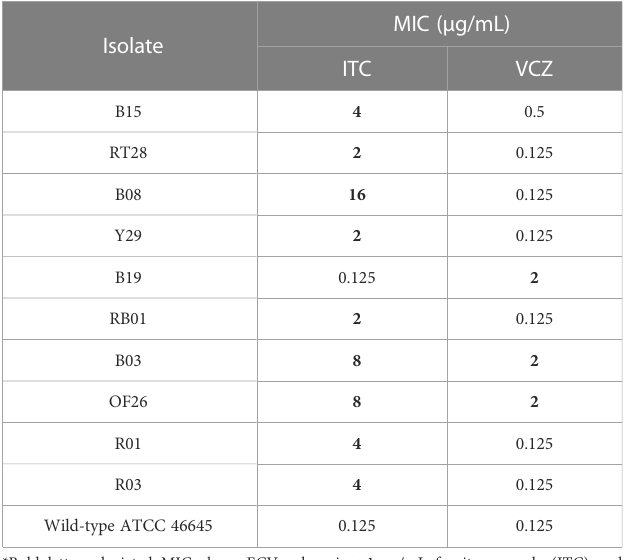
TABLE 3 Antifungal susceptibility pro fi le of 10 A . fumigatus isolates against azoles.